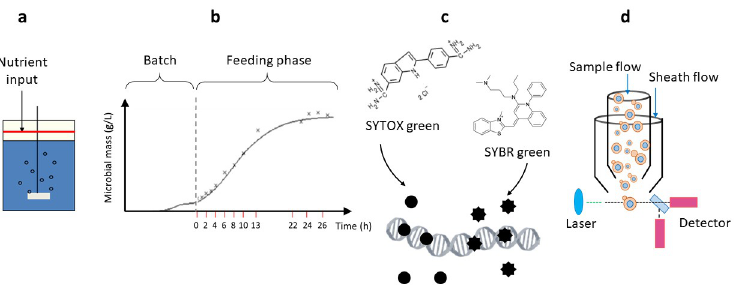
Fig 2. Overview of the experimental workflow. A fed-batch culture of Saccharomyces cerevisiae was performed in a stirred bioreactor (a) and sampled at different times during the cultivation starting from time 0 corresponding to a 15 h batch-cultivation (b). Fixed cells were stained (c) with either SYTOX Green or SYBR Green dyes for DNA detection. Finally, cells were analyzed by flow cytometer (d) as described in Materials and Methods.